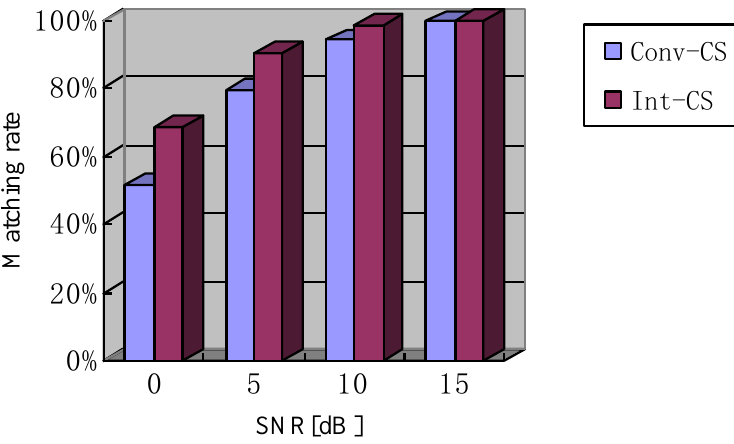
Figure 4. Comparison of matching rates for conventional CS (referred to as ‘Conv-CS’) and interaction CS (referred to as ‘Int-CS’) versus